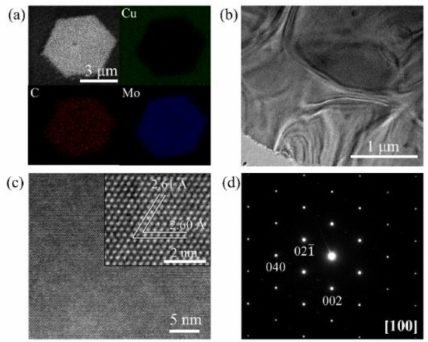
Figure 4. The characterization analysis of Mo 2 C. ( a ) The element distribution of Mo 2 C on Cu. ( b ) The transmission electron microscope (TEM) image. ( c ) The high-resolution TEM image of Mo 2 C. The inset image is a magnified image of a selected region. ( d ) The selected area electron diffraction (SAED) pattern along the [100] zone